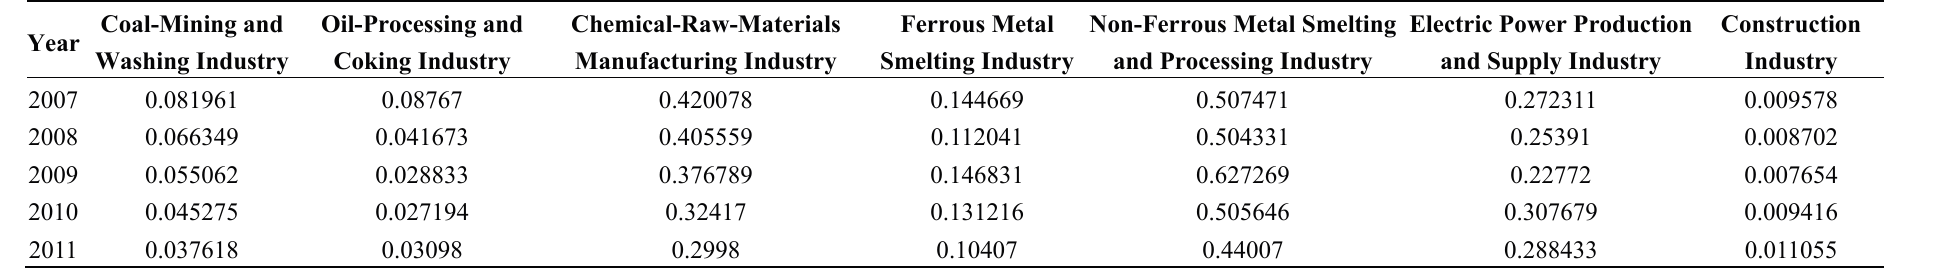
Table 17. The carbon emissions per 10 thousand yuan of industries in Shanxi Province from 2007 to 2011 (10 thousand tons).